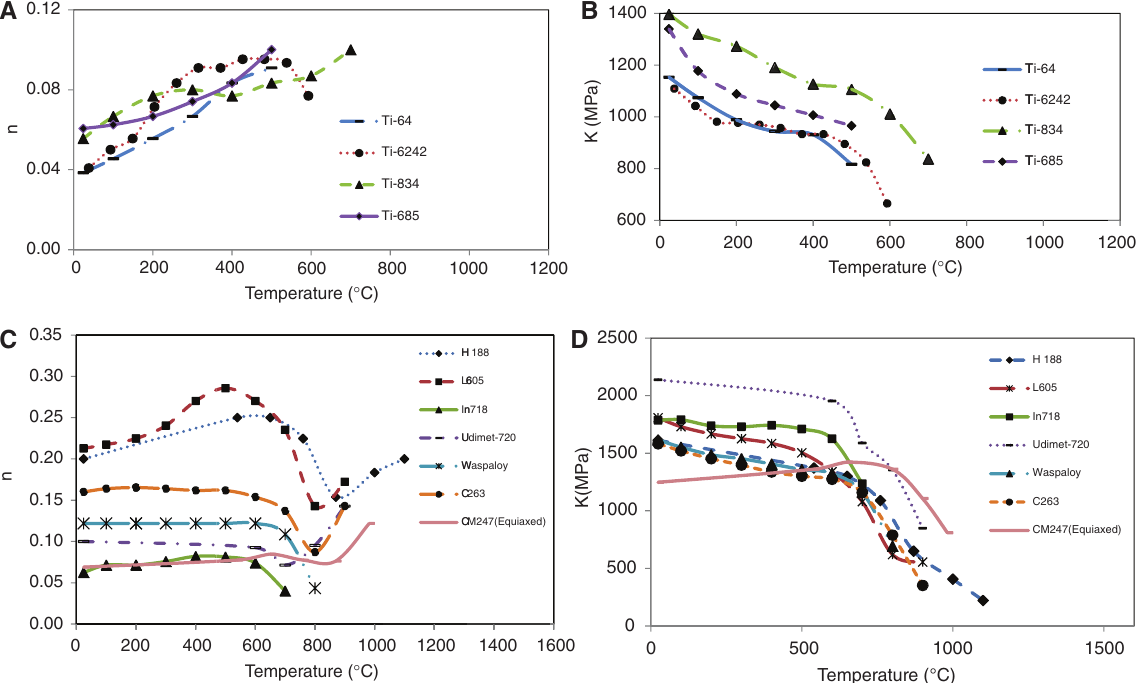
Figure 8 Variation of flow parameters for current aeroengine materials with temperature; (A) strain hardening exponents for tita- nium based alloys; (B) strength co-efficients for titanium based alloys; (C) strain hardening exponents nickel and cobalt based alloys; (D) strength co-efficients nickel and cobalt based alloys.